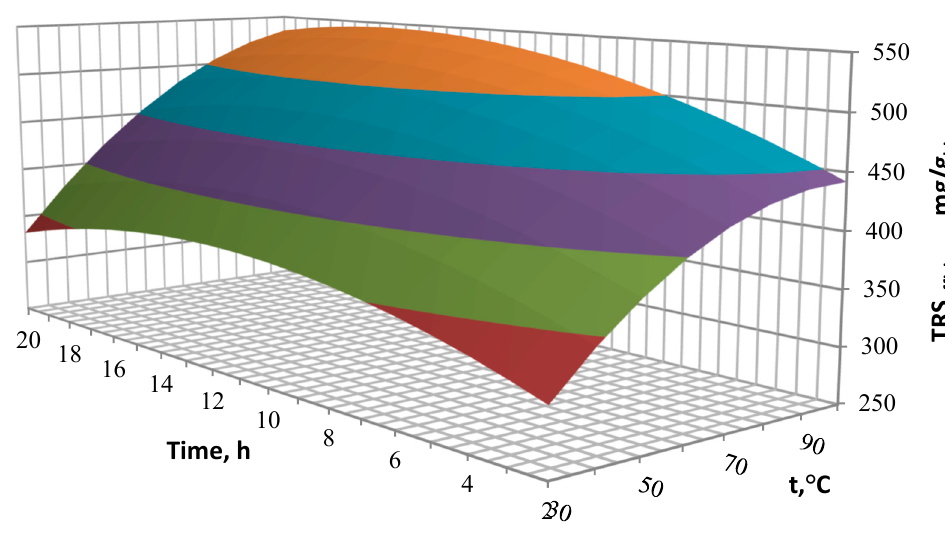
Figure 4. Influence of the pre-treatment time and temperature on the TRS efficiency.